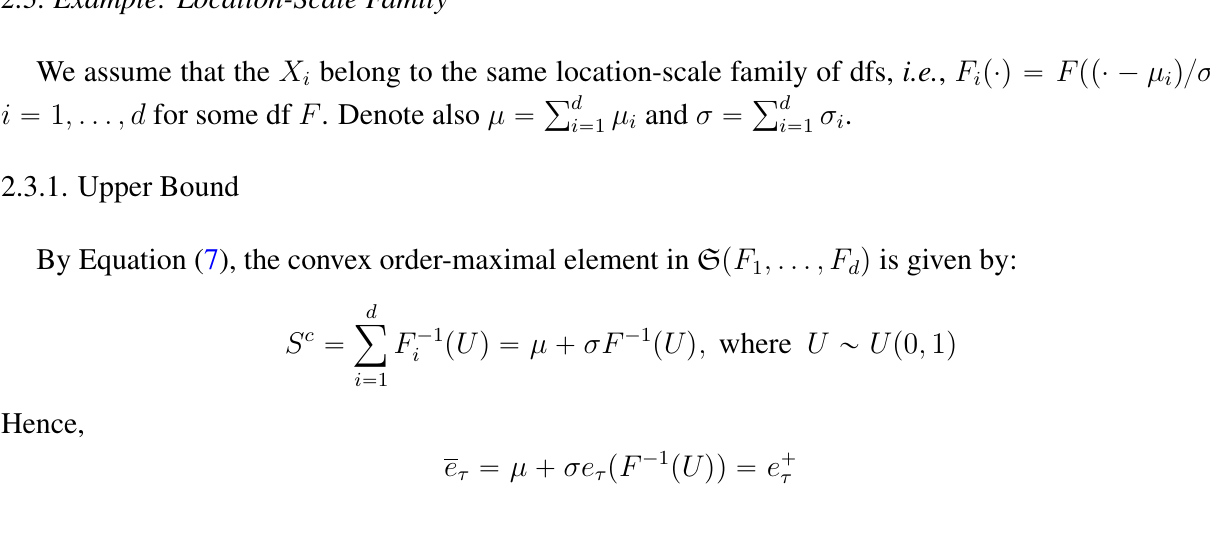
for d Pareto p θ q distributions, p